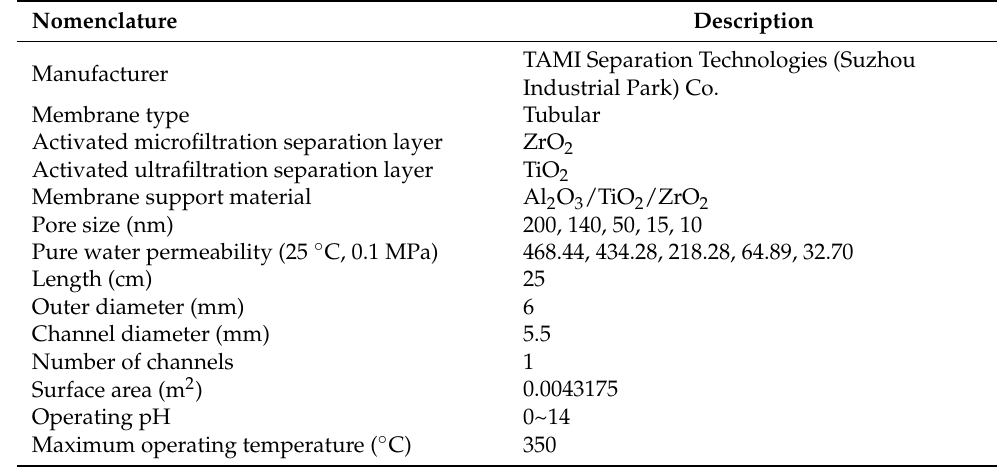
Table 1. Material characteristics and module details of the membrane system.